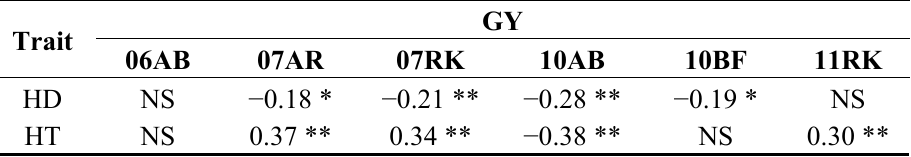
Table 2. Phenotypic correlations between grain yield (GY), heading date (HD), and plant height (HT) in the 159 RILs over six